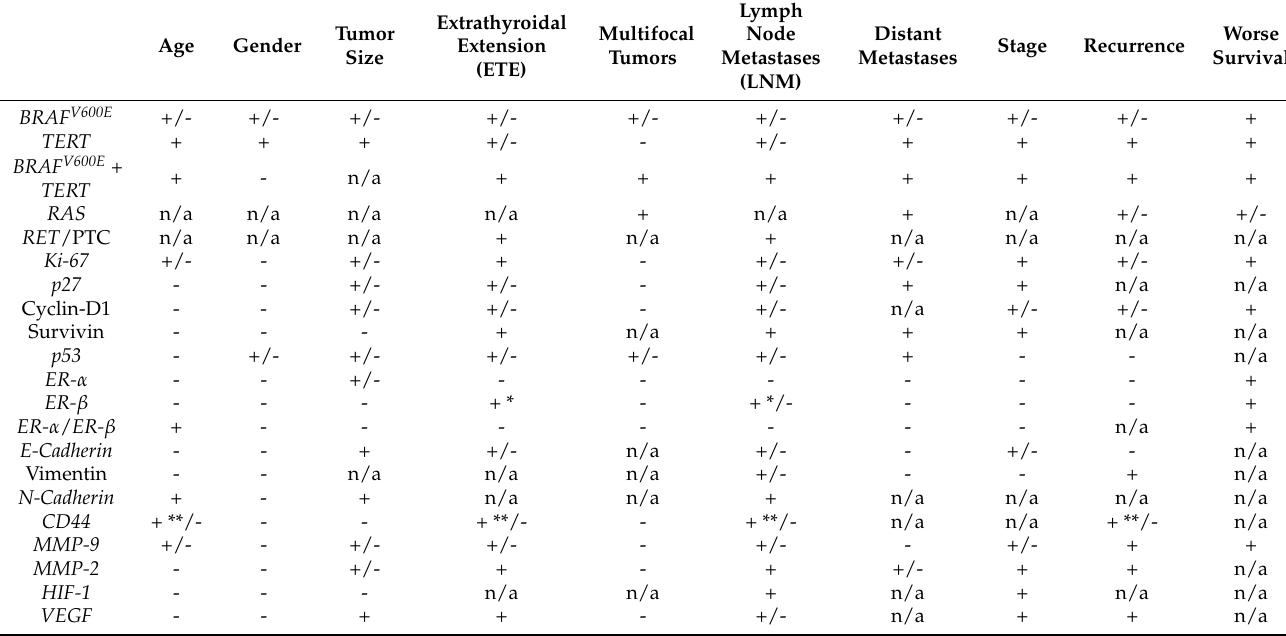
Table 1. Association of genetic and molecular markers with clinicopathological Differentiated thyroid cancer (DTC) features and